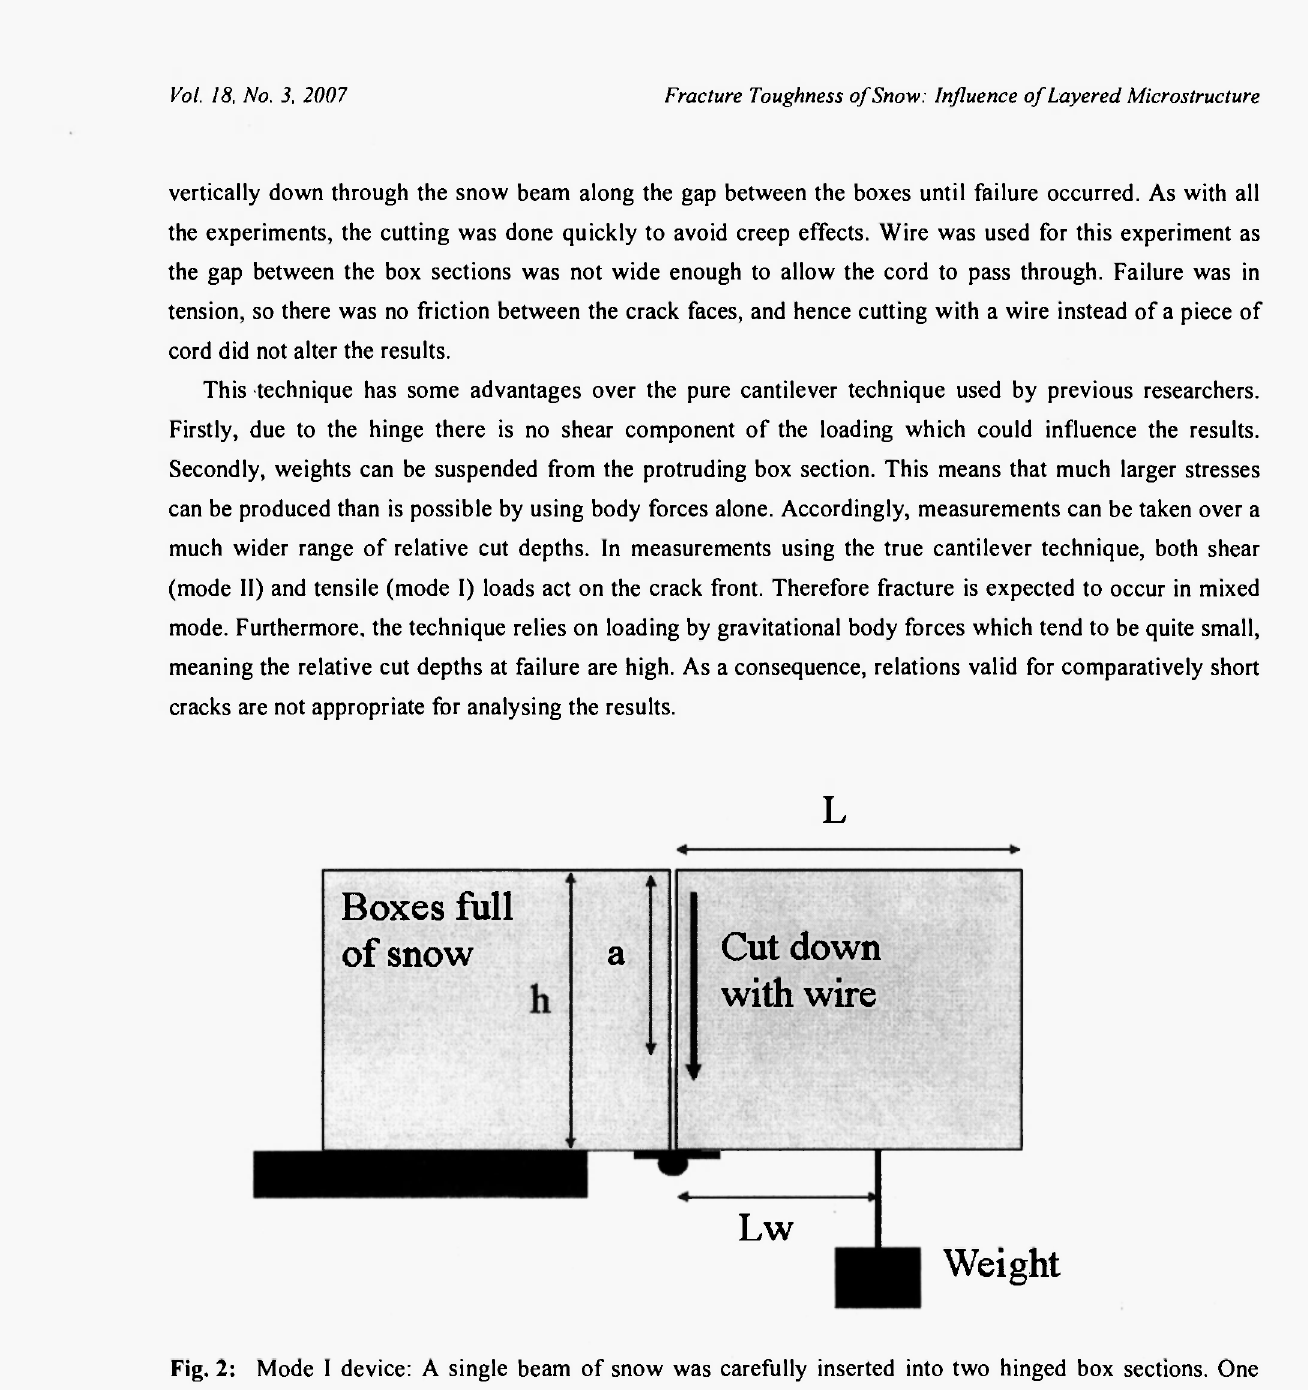
Fig. 2: Mode I device: A single beam of snow was carefully inserted into two hinged box sections.